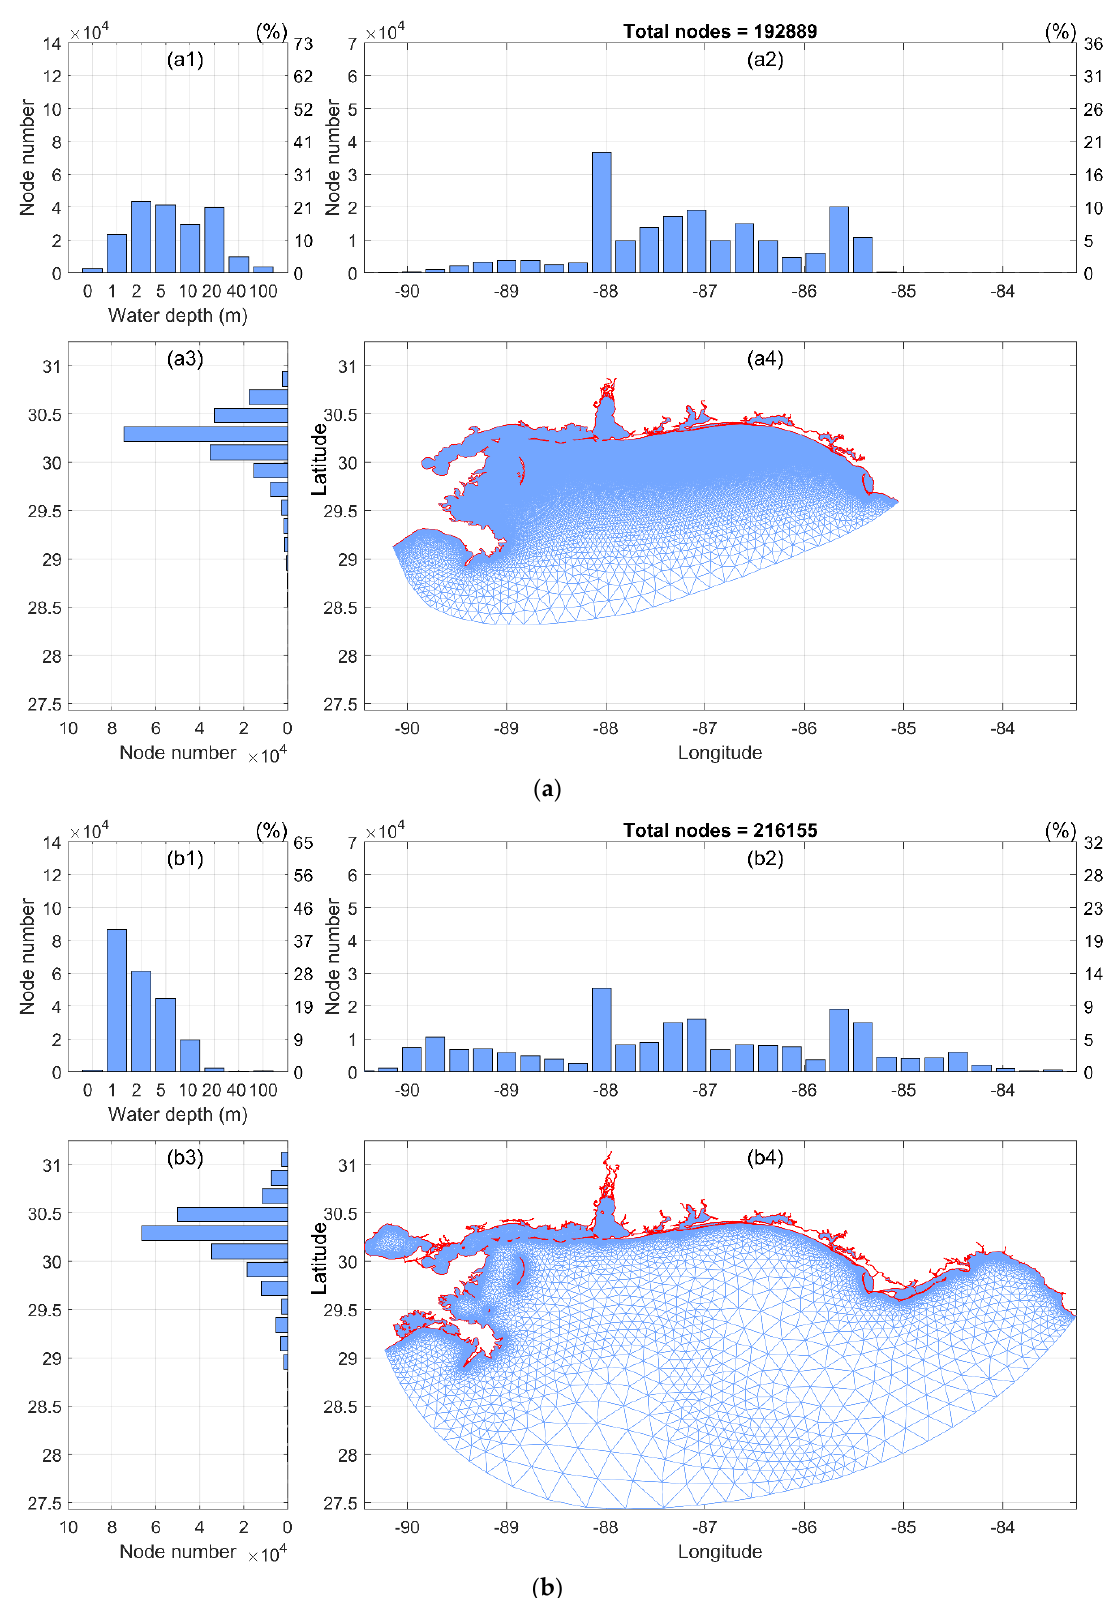
Figure 5. Comparison of the ( a ) 2008 and ( b ) new model meshes. ( 1–3 ) Histograms of node number versus depth, longitude, and latitude, respectively.